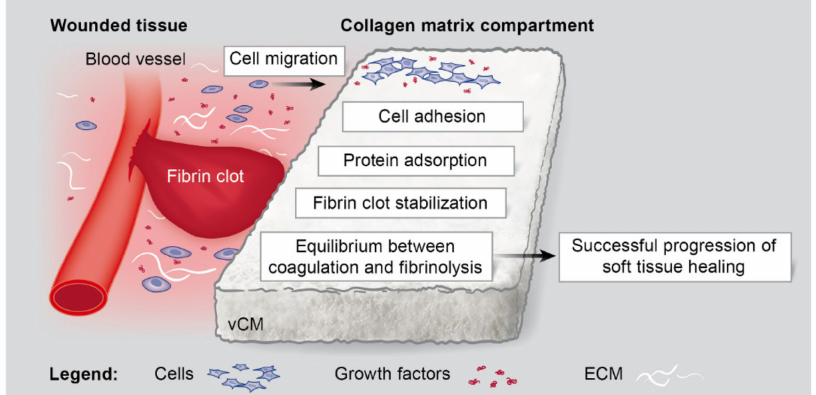
Figure 7. Schematic representation of the effects exhibited by vCM on the early events of the wound healing process. The ability of the vCM to affect the cellular migration and adhesion, protein adsorption, fibrin clot stabilization, and balance between coagulation and fibrinolysis, all as prerequisites for the successful continuation of the soft tissue healing process, are